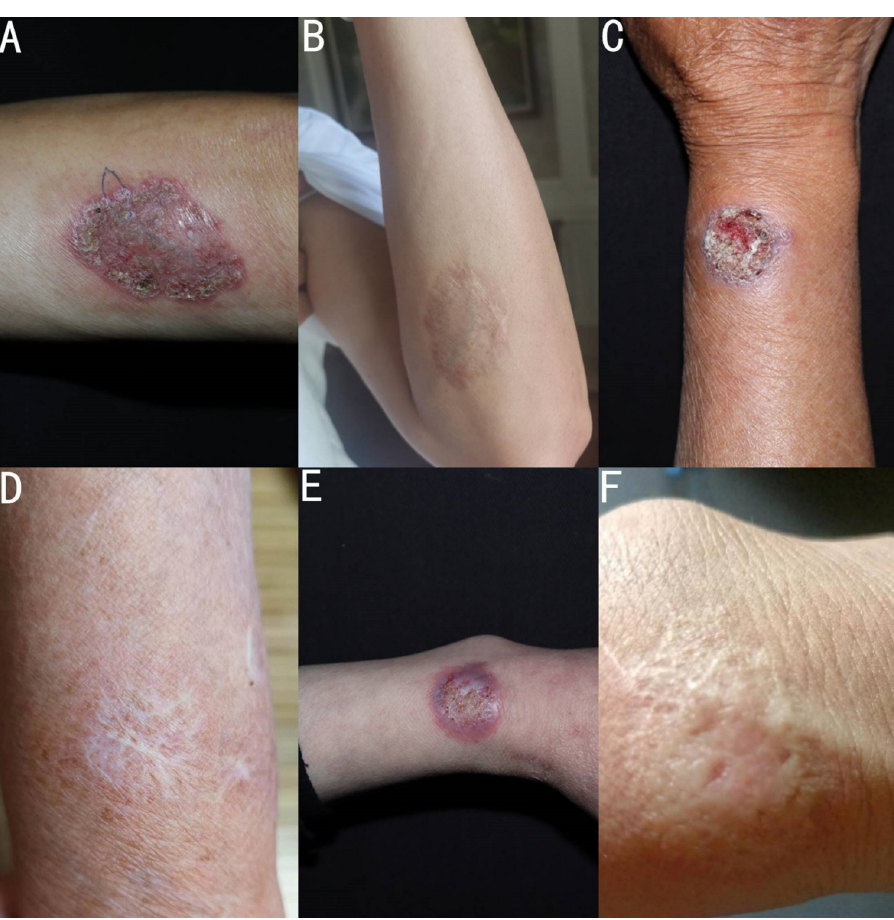
Fig 3. Mild form: Clinical picture of case 4, before treatment (A), and during 30 months of post-treatment follow-up (B). Clinical picture of case 8, before treatment (C), and during 14 months of post-treatment follow-up (D). Clinical picture of case 9, before treatment (E), and during 8 months of post-treatment follow-up (F).